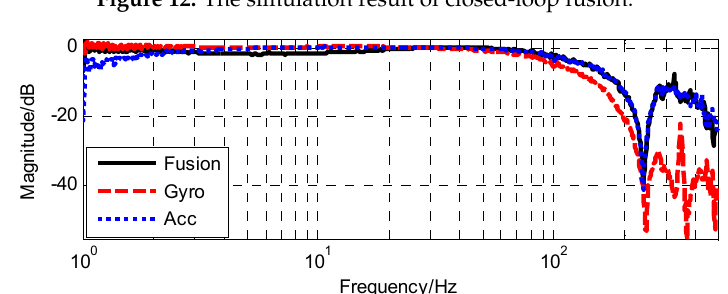
Figure 12. The simulation result of closed-loop fusion.